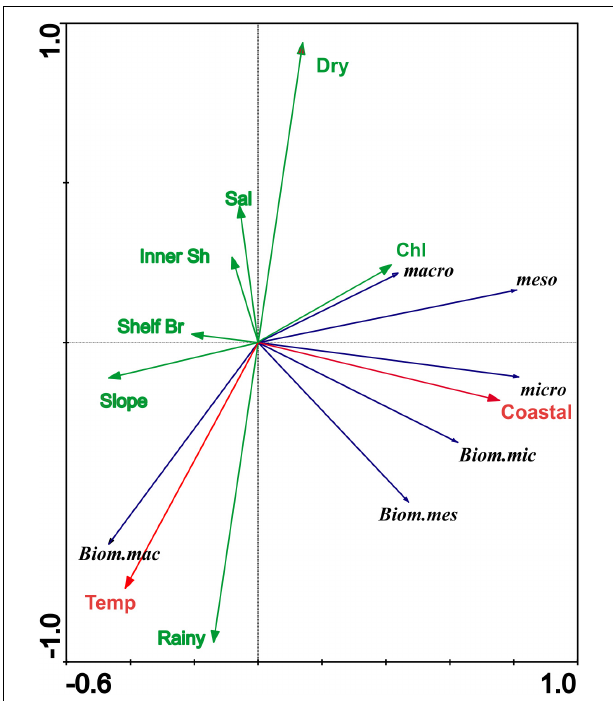
FIGURE 7 | Ordination diagram of the Redundancy Analysis (RDA). Significant vectors of spatial-temporal are in red, non-significant vectors in green, and taxon classification in blue for Zooplankton at the coastal and oceanic areas off Rio Grande do Norte, Southwestern Atlantic. Areas: Coastal, Inner Shelf, Shelf Break, and Slope; Rainy: Rainy season; Dry: Dry season: Sal: Salinity; Chl: Chlorophyll a ; macro: macrozooplankton; meso: mesozooplankton; micro: microzooplankton; Bio_macro: biomass macrozooplankton; Bio_meso: Biomass mesozooplankton, and Bio_micro: biomass microzooplankton.